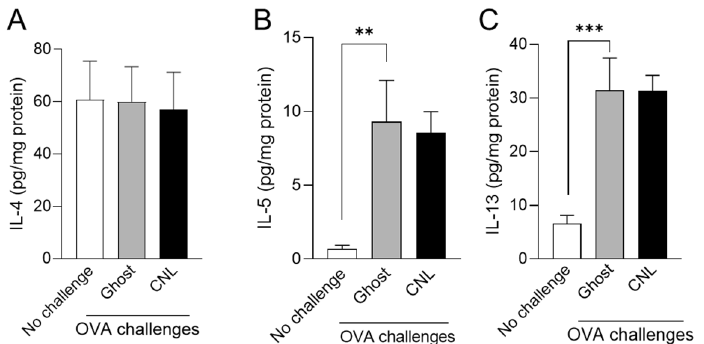
Figure 4. Effects of ceramide nanoliposomes (CNL) on the formation of type 2 cytokines in the lung. Asthmatic mice were treated with 30 μg/animal Ghost or CNL. Type 2 cytokines levels including IL-4 ( A ), IL-5 ( B ), and IL-13 ( C ) in the lung tissues were measured by ELISA. Concentration of type 2 cytokines were normalized to protein. Data are shown as mean ± S.E. ( n = 12). ** p < 0.01, *** p < 0.001 compared to the Ghost group.